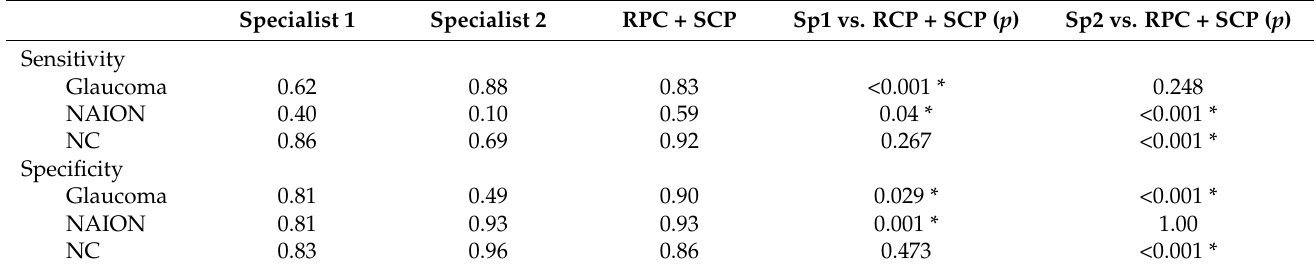
Table 4. Comparison of sensitivity and specificity between deep learning classifier and specialists’ classification using the bilateral McNemar test.